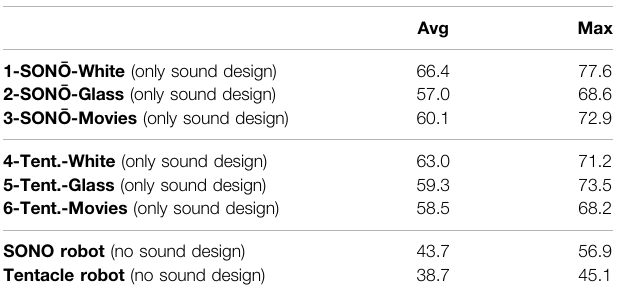
TABLE 1 | Average and maximum sound levels (in decibel) for the sounds occurringinthe twoexperiments. Thesound levels ofthe sound designs have been measured without the robot moving. The mechanical sound of the robots themselves has been measured without any sound playing on the loudspeaker. The measurements were done with the robots and the loudspeaker positioned on the table and cloth as described above. A sound meter was positioned at a fi xed distance of 1 m to the robot corresponding to the approximate distance and height at which the sound would be heard by a